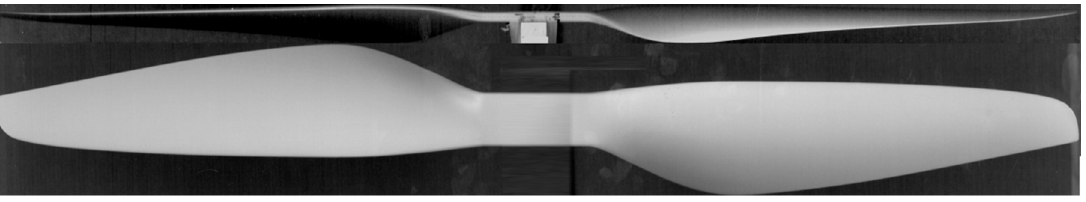
Figure 3. T-Motor 16 inch × 5.4 inch isometric top and side view images taken with a conventional scanner.